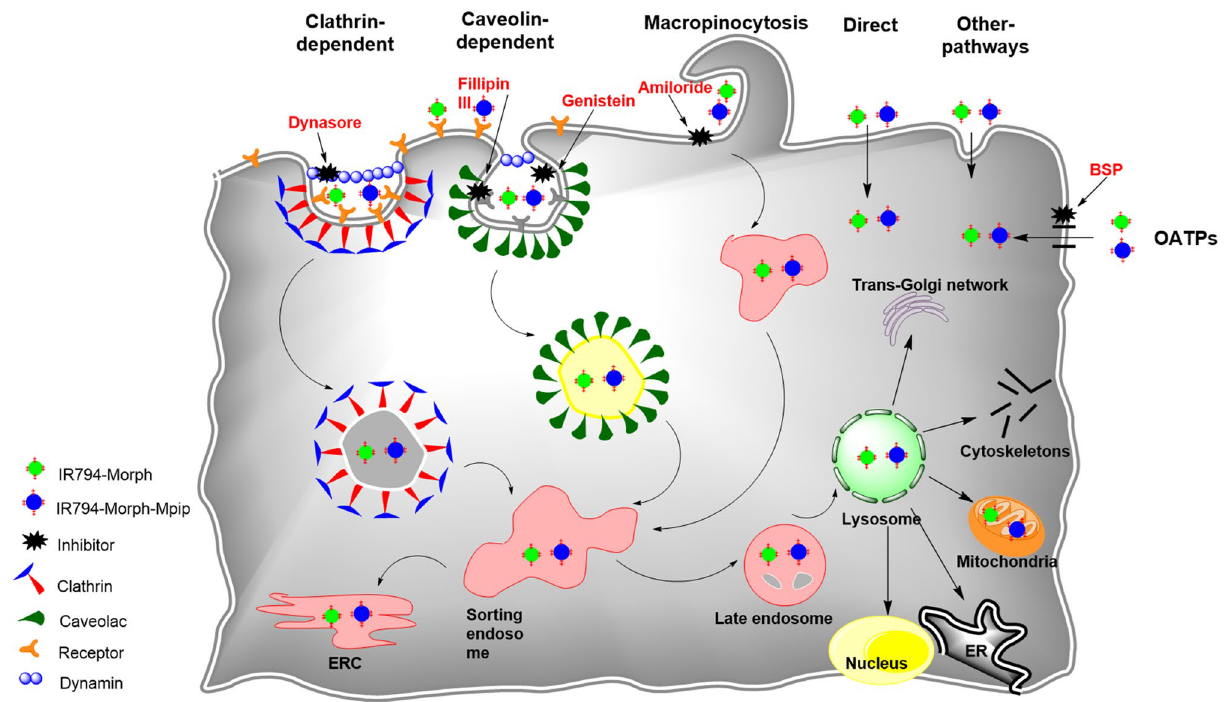
Figure 10. Schematic representation of the possible internalization pathways of IR794-Morph and IR794- Morph-Mpip